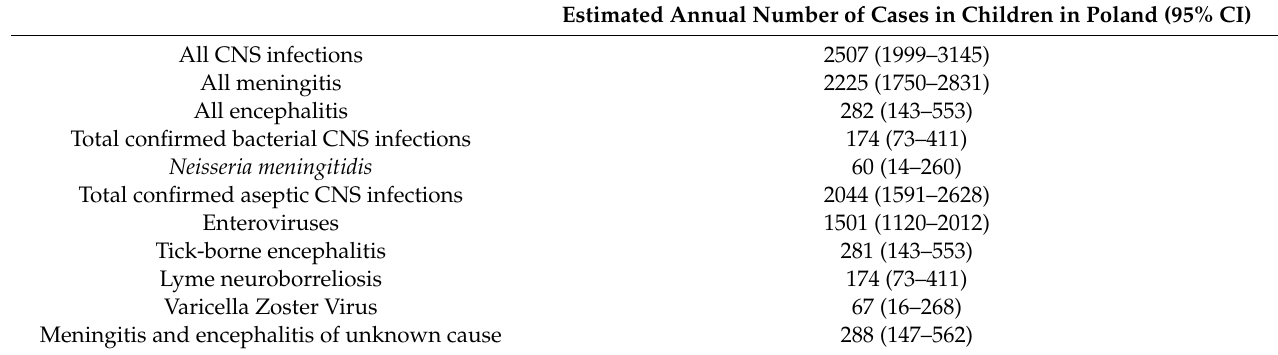
Table 4. Estimated number of cases a year in Poland in children <